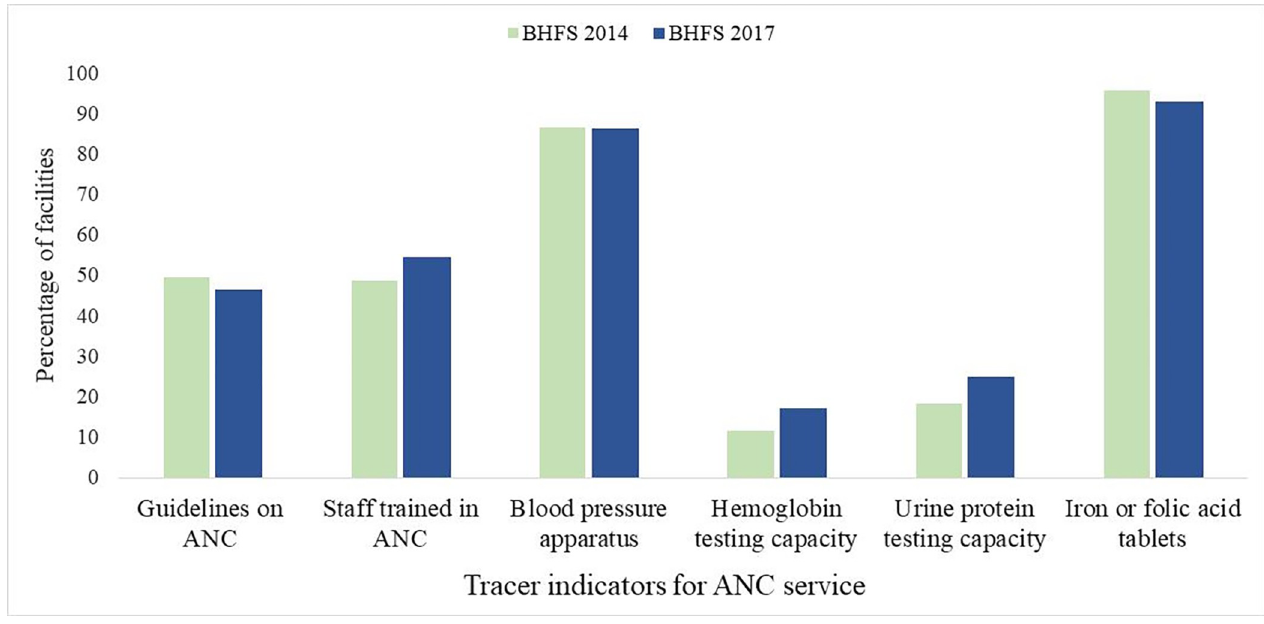
Fig 2. Availability of tracer indicators in healthcare facilities measuring preparedness to offer ANC service by survey year.